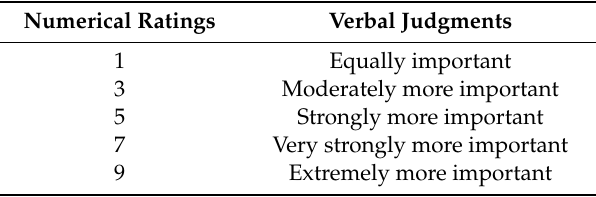
Table 7. Pair-wise comparison rating scale [29].